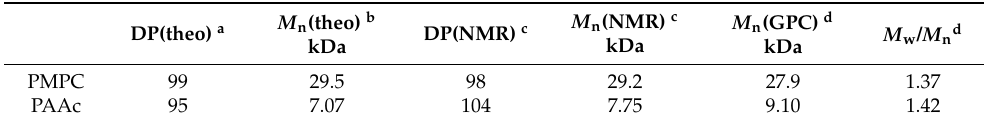
Table 1. Degree of polymerization (DP), number-average molecular weight ( M n ), and molecular weight distribution ( M w / M n